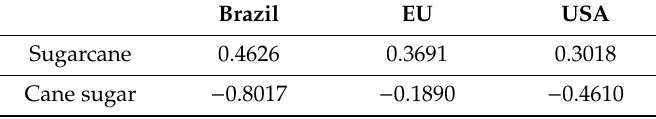
Table 1. Correlations (r) of sugarcane and cane sugar exports with ethanol production.